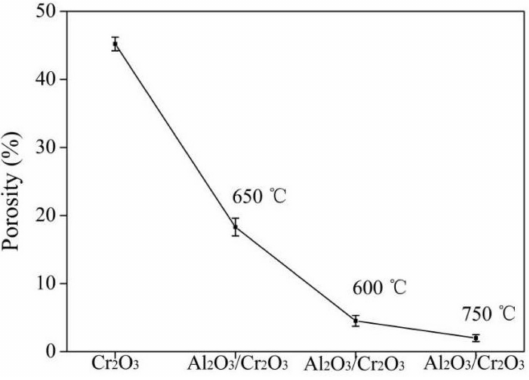
Figure 4. Porosity of the Cr 2 O 3 coating and the sealed Cr 2 O 3 coatings heat-treated at different